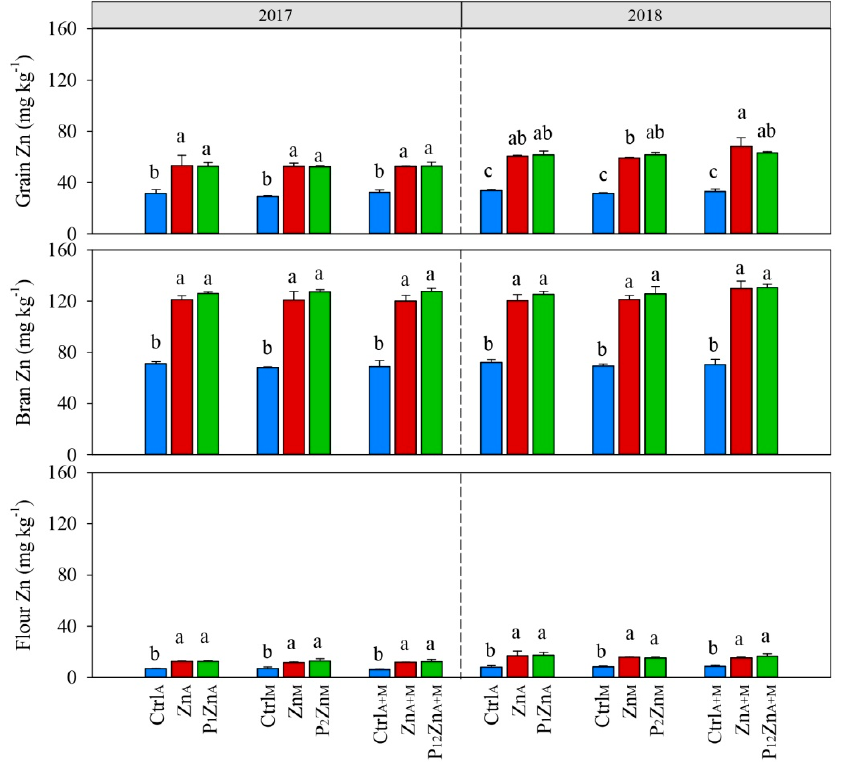
Figure 3. Zinc concentrations in grain, bran, and flour of wheat plants harvested in 2017 and 2018. Treatments consist of nil Zn spray (control, Ctrl) and foliar Zn application alone (Zn) or plus pesticides (PZn) at the anthesis (A), milk stage (M) or both (A+M). Pesticides were a mixture of fungicide + insecticide which were thiophanate-methyl + beta-cypermethrin at anthesis (P 1 Zn A ) and triadimefon + imidacloprid at milk stage (P 2 Zn M ). Vertical bars represent the standard error of four replications. Columns with no letter in common indicate significant differences between treatments each year by LSD test ( p < 0.05). Across the two-year data, strong and positive correlations were found between grain yield and grain Zn uptake in both control groups and foliar Zn spray groups ( r 2 = 0.83 to 0.86, p < 0.001) (Figure 4a). However, the correlation between grain Zn concentration and yield was negative and only significant in the foliar Zn treatments ( r 2 = 0.64, p < 0.001), and not in the plants without Zn application ( p > 0.05) (Figure 4b). Figure 4. The correlation analysis of grain Zn uptake ( a ) and concentration ( b ) against grain yield in wheat with nil Zn application (control) and foliar Zn spray (with and without pesticides). The arrow pointing data were removed from the trend-line to give a higher r 2 . ***, p < 0.001; n.s., not significant.